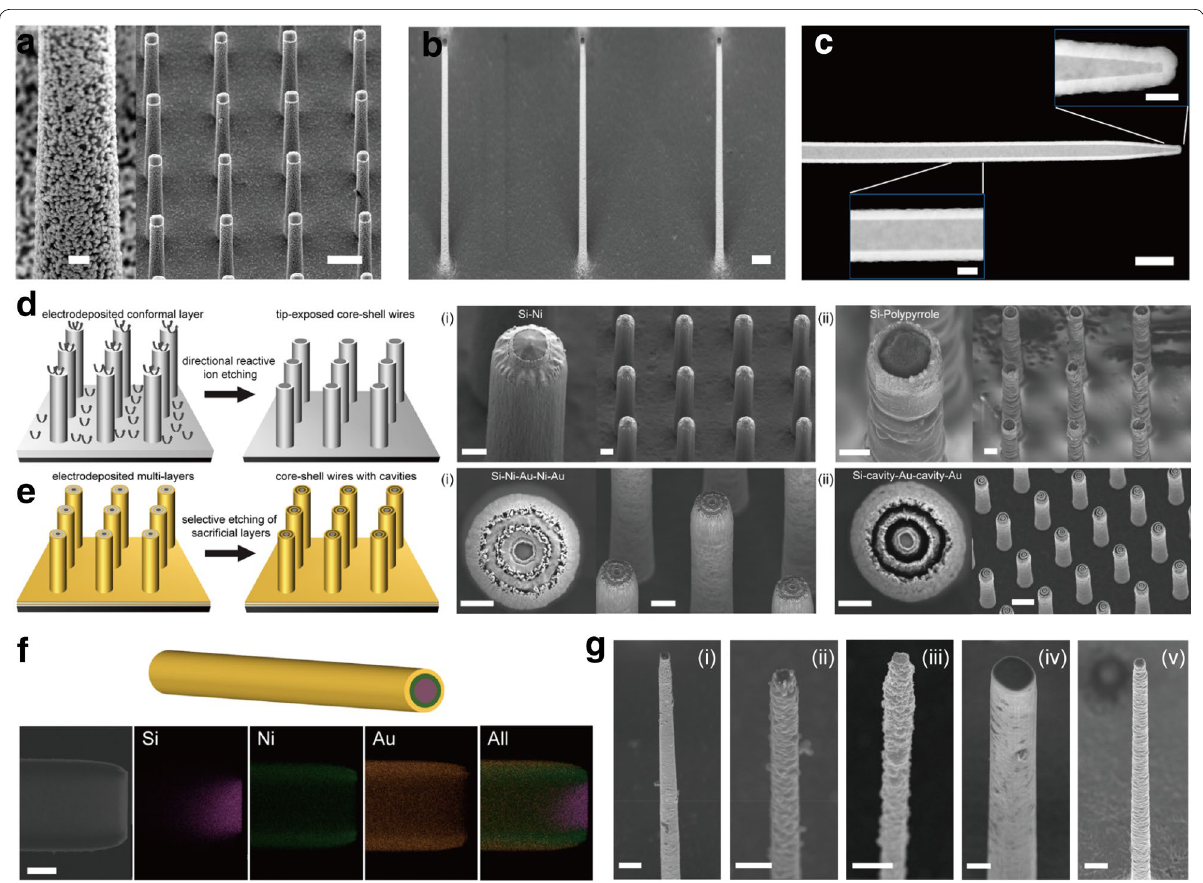
Fig. 8 Conformal and uniform deposition of various materials on high‑aspect‑ratio silicon micro/nanowires for coaxial/multilayered cylindrical architectures. a Top‑down fabricated Si wire array homogeneously decorated with Ni nanoparticles. b High‑aspect‑ratio Si NWs covered with a thin Ni layer. c Low‑ and high‑resolution STEM images for detailed characterization of a uniformly deposited Ni film on a Si wire. d Schematic illustra‑ tion of tip‑exposure of core/shell wires (left) and SEM images of tip‑exposed core/shell Si/Ni (middle) and Si/polypyrrole (right) wires. e Schematic illustration of multilayer uniform deposition for core/shell wires (left) and SEM images of Si/Ni/Au/Ni/Au (middle) and Si/cavity/Au/cavity/Au (right) wires. f Schematic illustration of a Si/Ni/Au core/shell NW (top), STEM image of the fabricated wire (bottom, left) and corresponding elemental map‑ ping images of the above wire. g Deposition of different materials on Si wires: (i) rhodium, (ii) polyaniline, (iii) cadmium selenide, (iv) Ni/polyaniline shell, (v) Ni/Ru shell ( a – g are adapted from